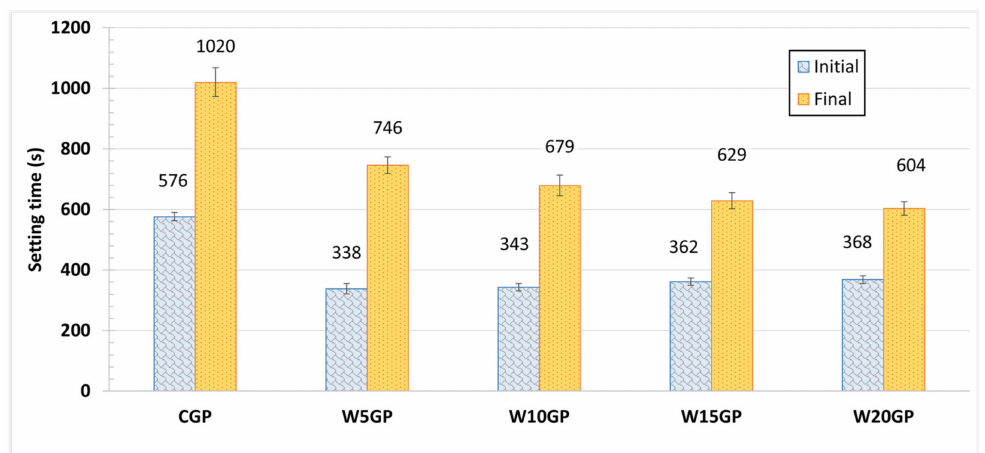
Figure 3. Setting times of CGP and WGP